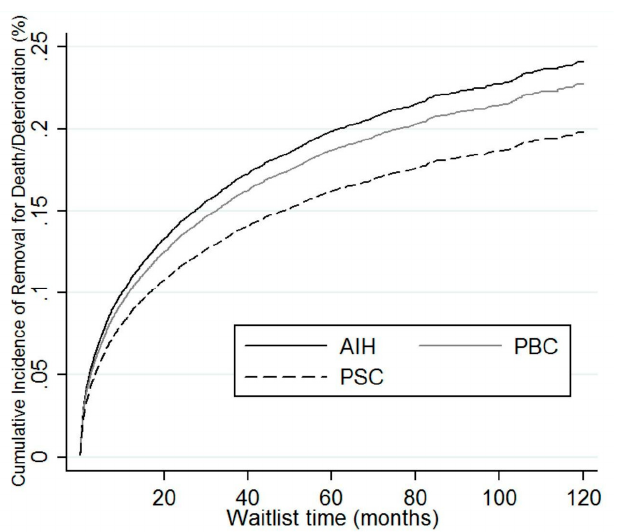
Figure 2. Competing risk regression of AIH, PBC, and PSC demonstrating relative removal from waitlist for death or deterioration. AIH: autoimmune hepatitis; PBC: primary biliary cholangitis; PSC: primary sclerosing cholangitis.